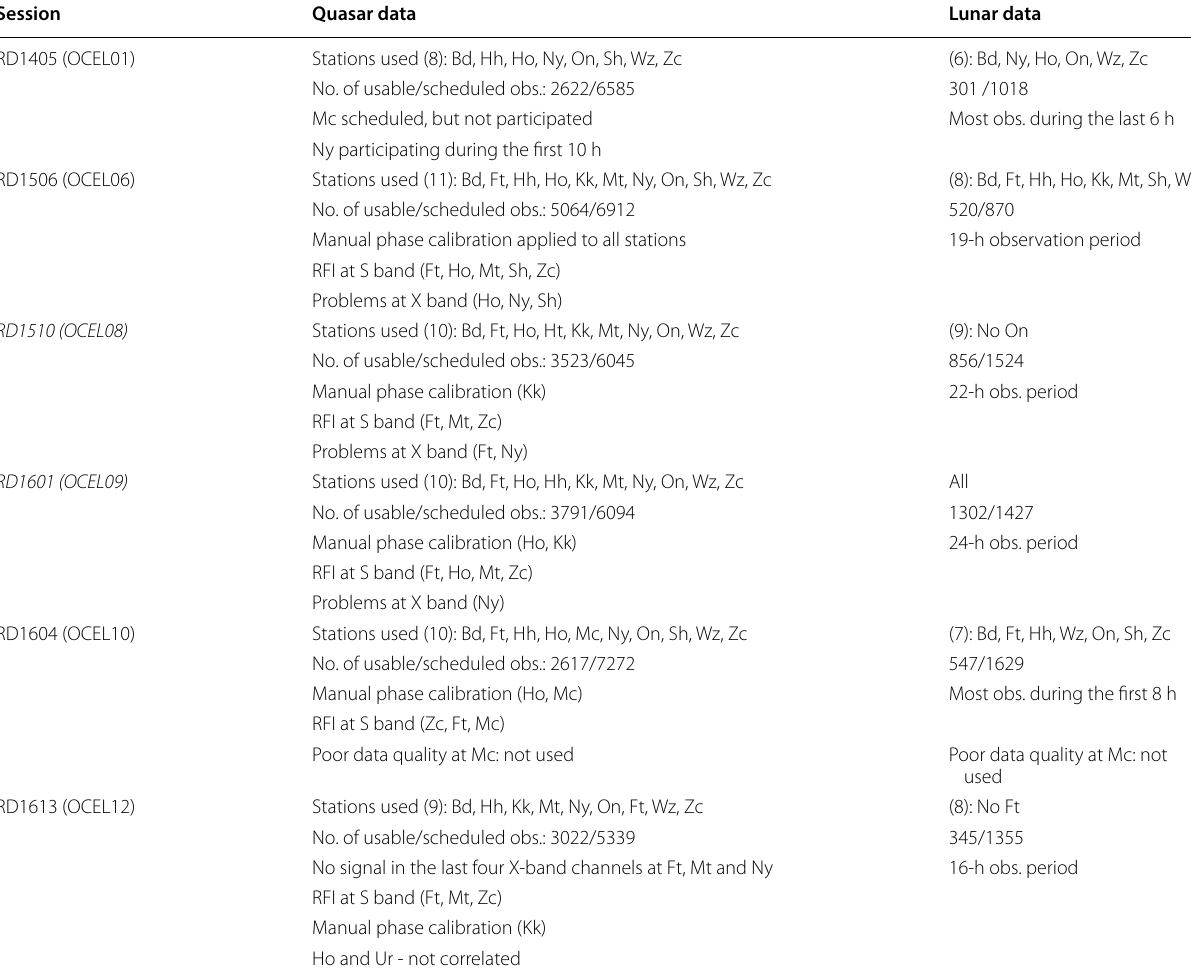
Table 1 Characteristics of OCEL sessions and problems encountered during the analysis, shown for the selected